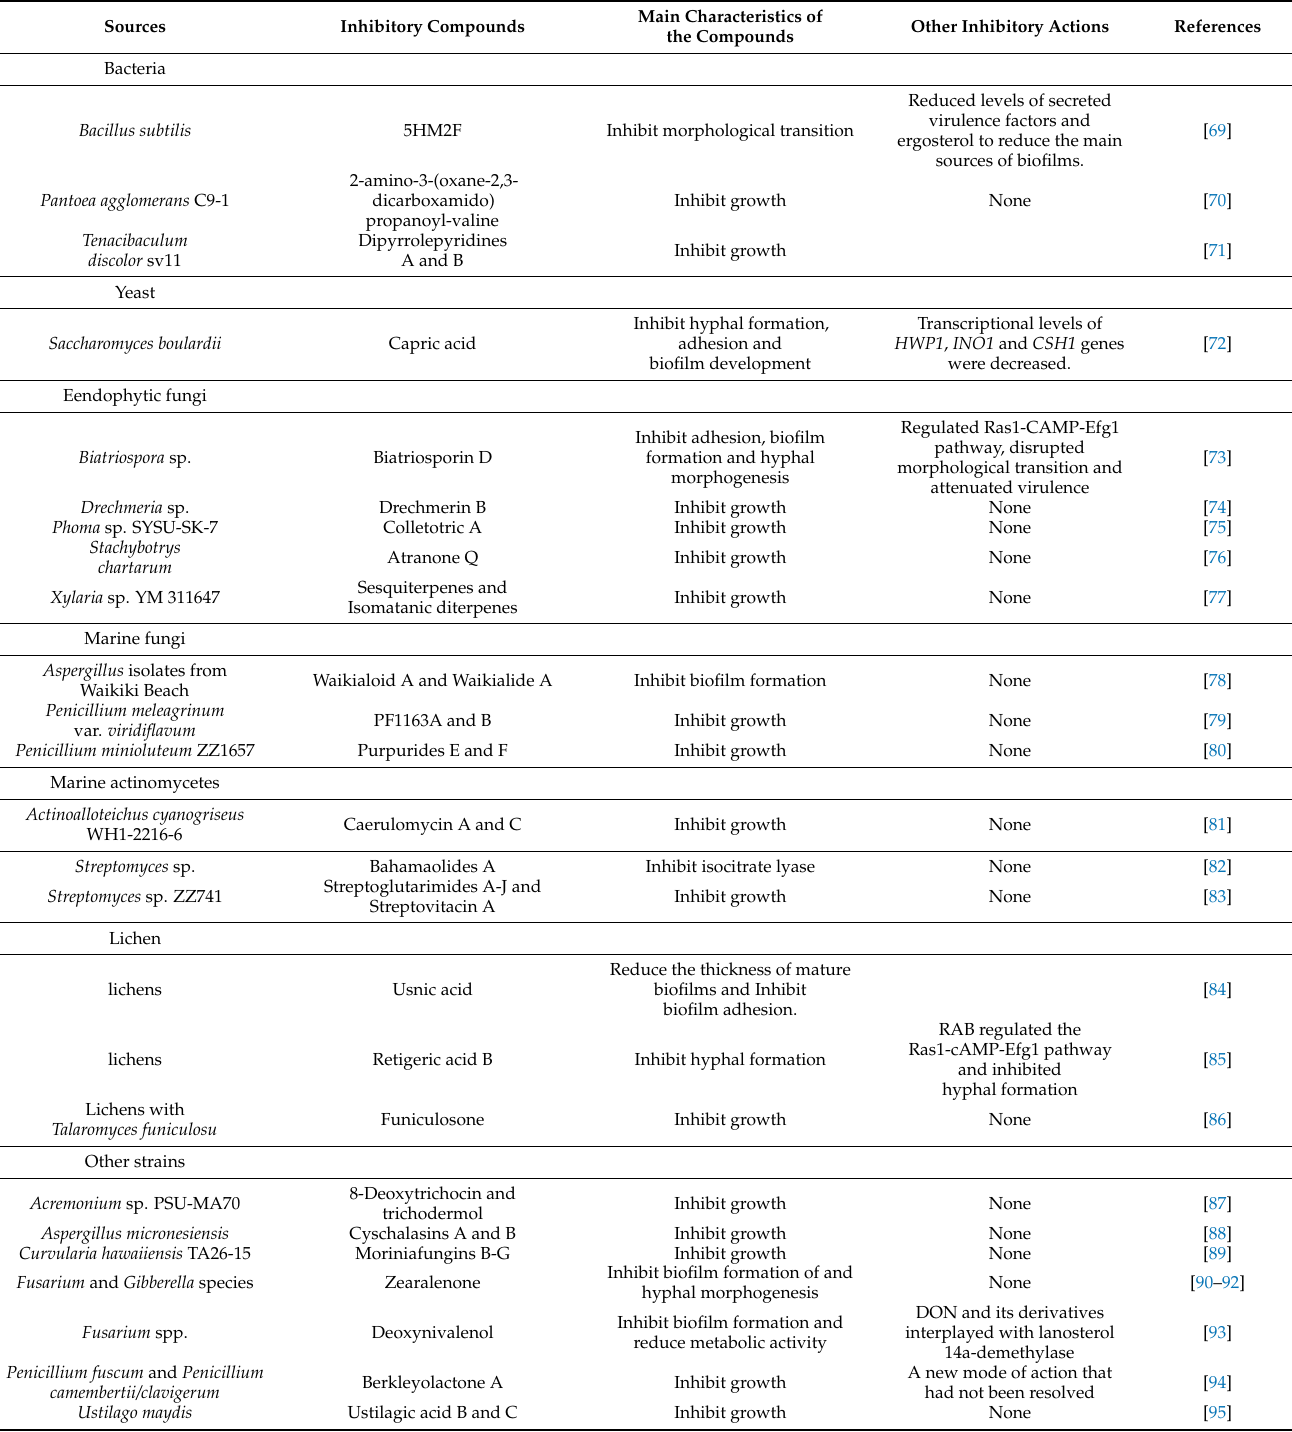
Table 2. Inhibitory nature metabolites produced by antagonists against C. albicans